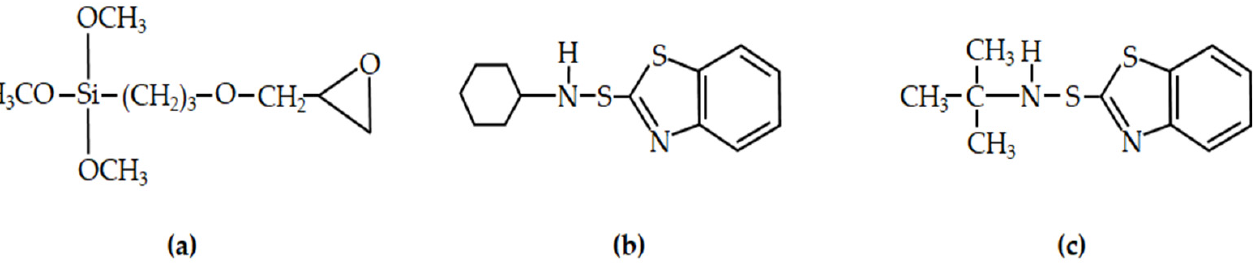
Figure 1. Chemical structures of ( a ) GPTMS, ( b ) CBS, and ( c ) TBBS.